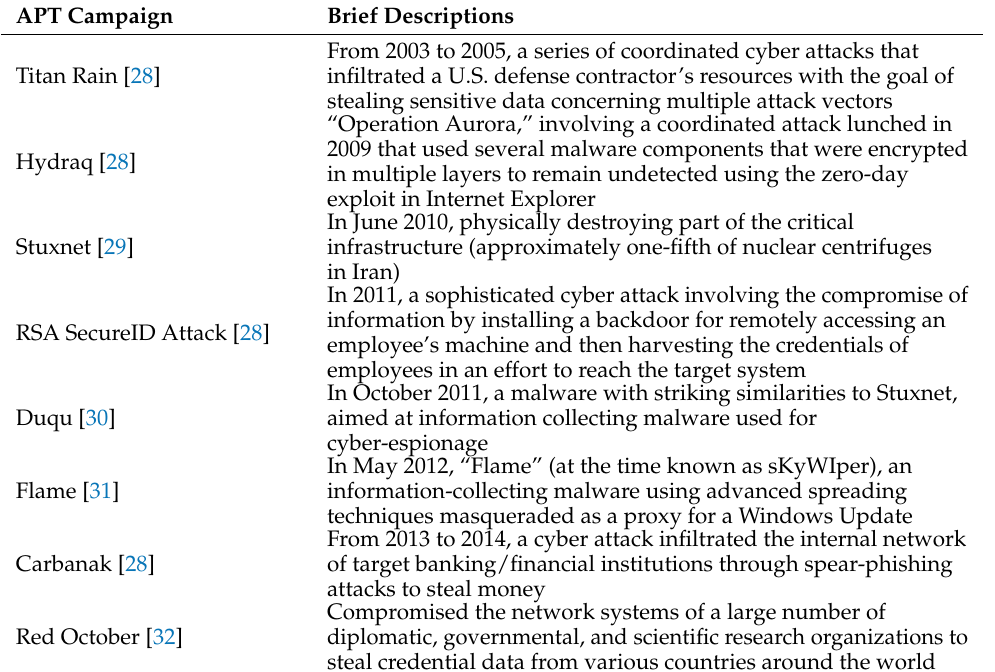
Table 2. Several APT case